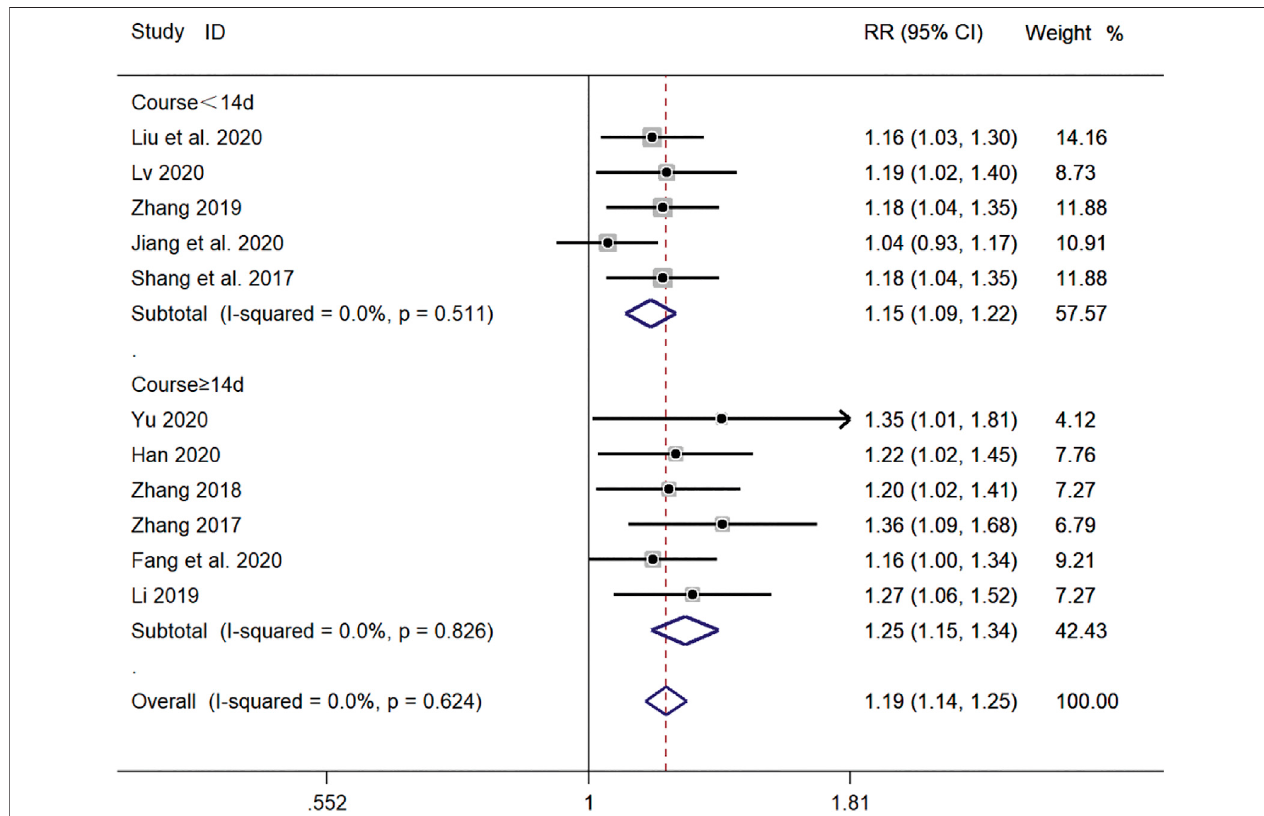
FIGURE 12 | Meta-analysis forest plot comparing the total ef fi ciency level of the experimental group with the control group for subgroup analysis of different treatment duration.